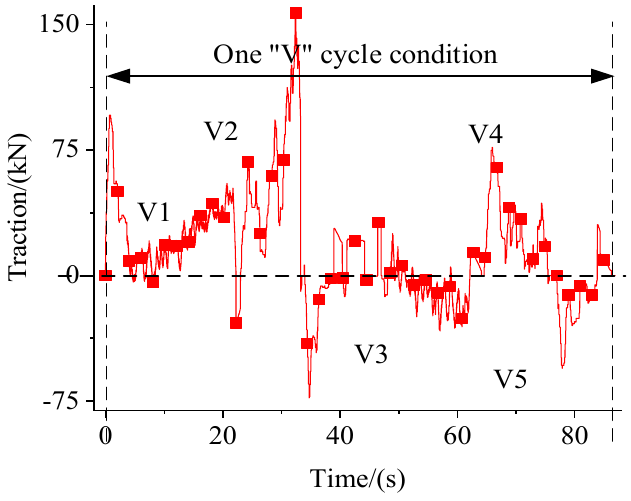
Figure 22. The load spectrum of the actual loader under the typical “V” cycle.